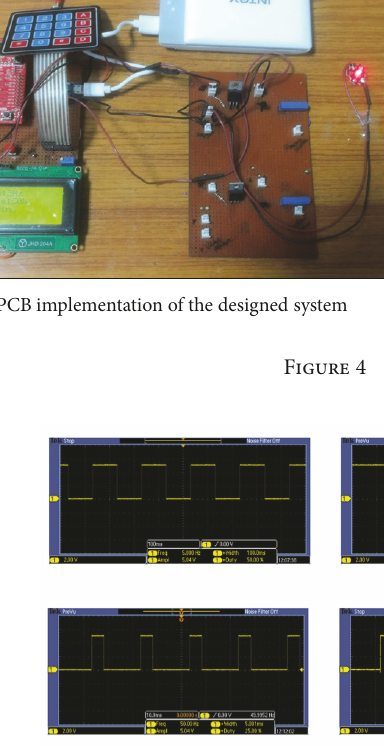
Figure 5: Waveforms of pulsed wave with variable frequency and duty cycle.